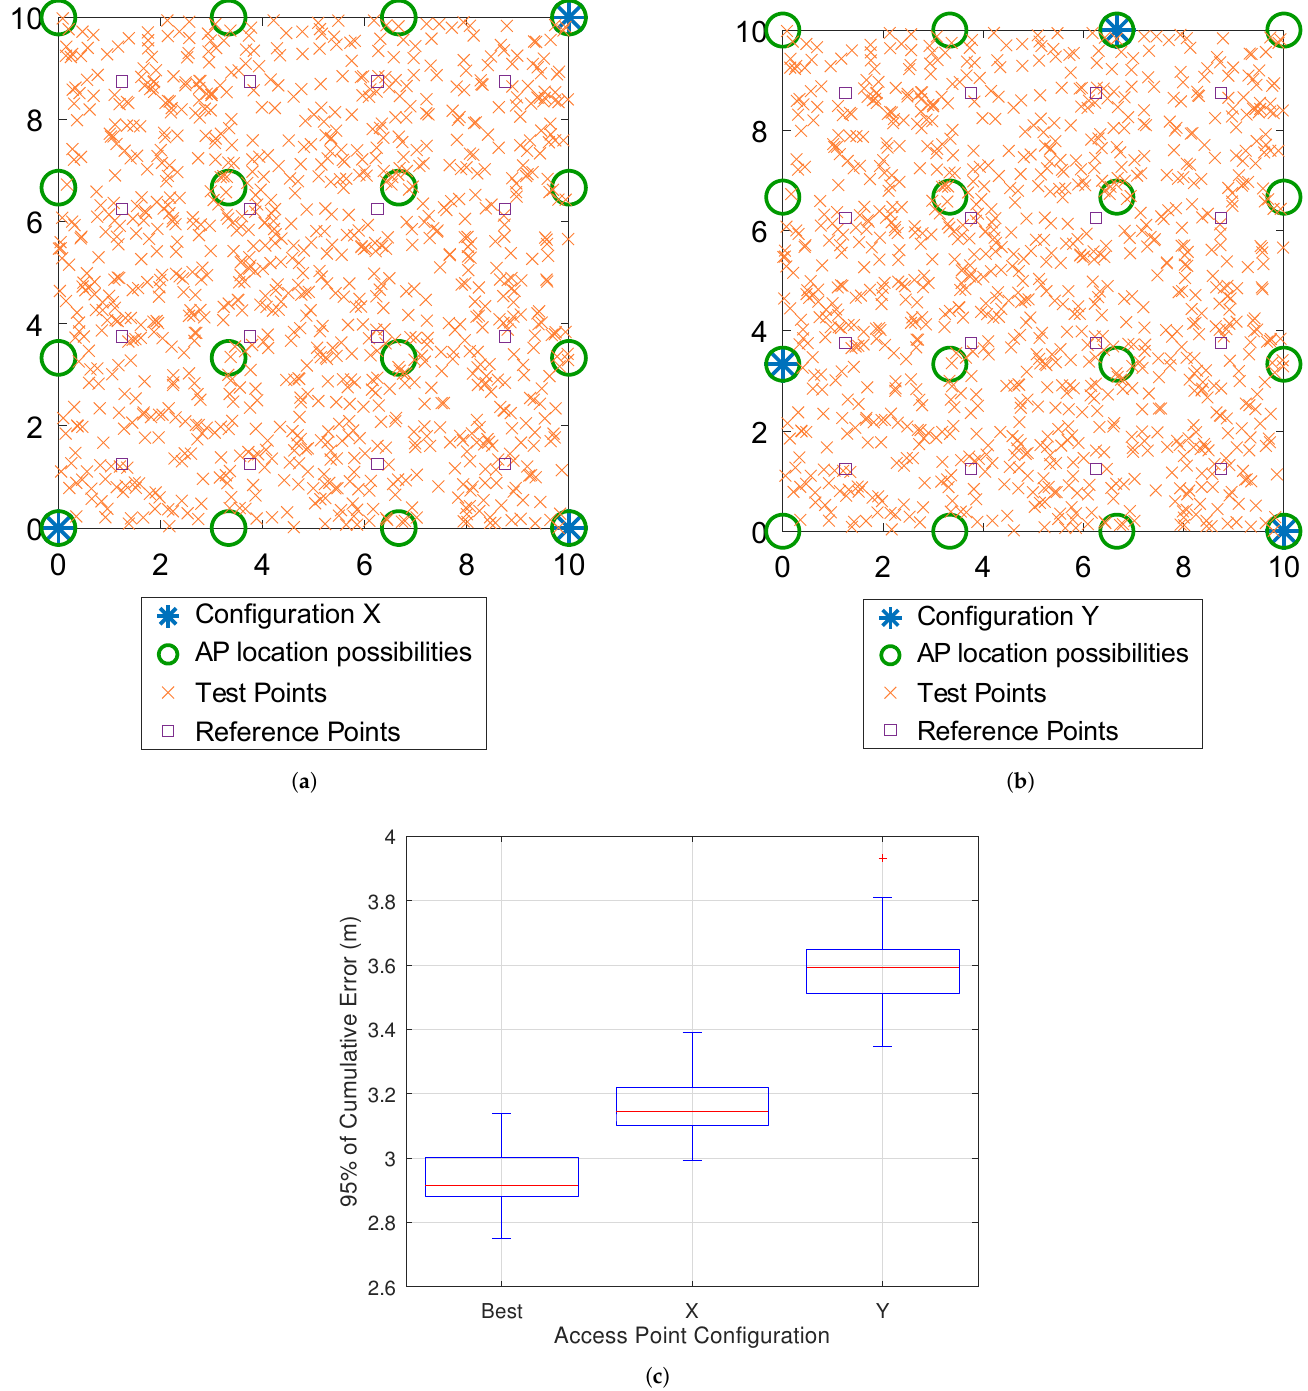
Figure 9. Simulated scenarios (3 APs, 16 RPs and 10 samples per test) with different AP arrangements: ( a ) APs at the corners of the room—X; ( b ) APs in a similar format to an equilateral triangle—Y; ( c ) Error comparison among best, X, and Y